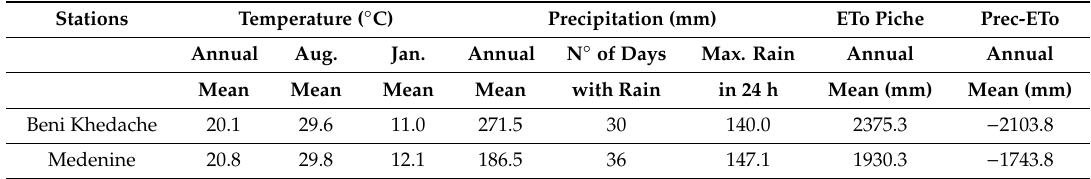
Figure 1. Location of the study area (Zammour) on the Matmata-Dahar plateau, Southeast Tunisia. Modified after Ben Fraj et al. [7]. Table 1. Main climate features in Beni Khedache (1990–2004) and Medenine (1968–2004) in Southeast Tunisia according to the National Meteorological Institute of Tunisia [37,38].